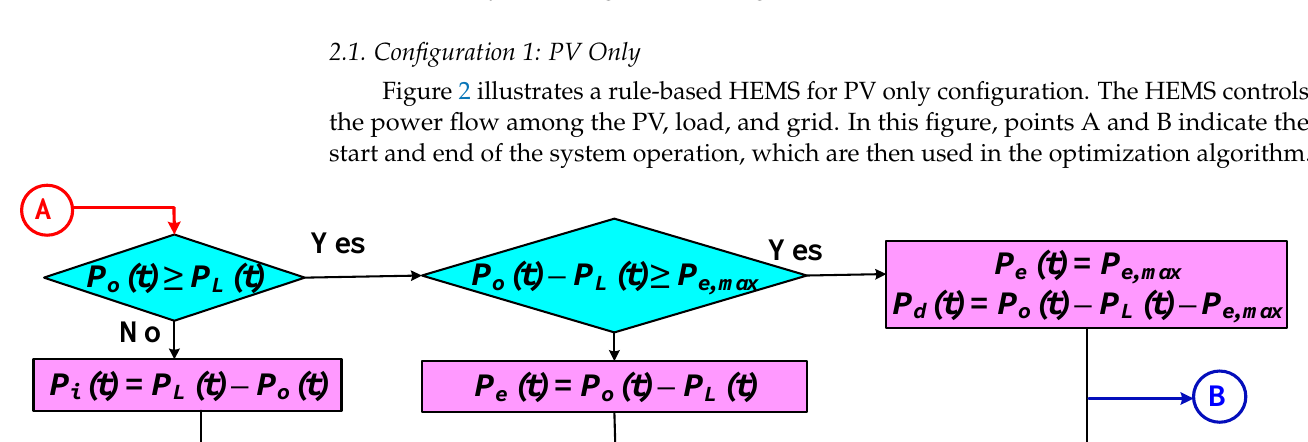
Figure 1. Two system configurations for a grid-connected house.